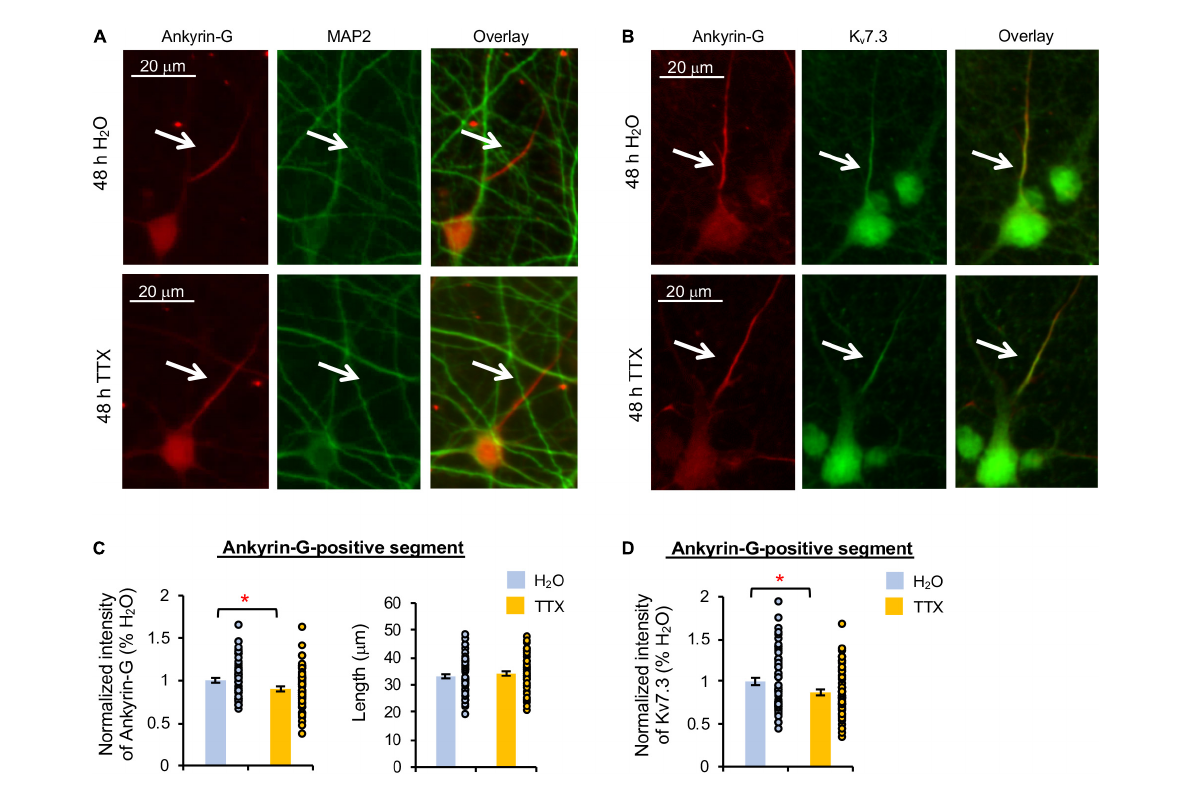
FIGURE3 Prolonged activity blockade decreases K v 7.3 and ankyrin-G expression at the AIS. Cultured hippocampal neurons (DIV 11–12) were treated for 48 h with 1 µ M TTX or its vehicle control (0.1% H 2 O) and subjected to immunocytochemistry with antibodies for the AIS marker ankyrin-G, somatodendritic marker MAP2, or K v 7.3. (A) Representative images of ankyrin-G and MAP2. (B) Representative images of ankyrin-G and K v 7.3. (C) Quantification of the background-subtracted raw integrated fluorescent intensity of ankyrin-G-positive segment in the axon, which was normalized to vehicle control, and the length of the ankyrin-G-positive segment. (D) Quantification of the background-subtracted raw integrated fluorescent intensity of K v 7.3 within the ankyrin-G-positive segment, which was normalized to vehicle control. Data shown represent the mean ± SEM with individual data points (H 2 O = 62 neurons from 46 images, TTX = 61 neurons from 43 images). Images were collected from 2 independent experiments. The Student’s t -test was used (* p < 0.05). Scale bar = 20 µ